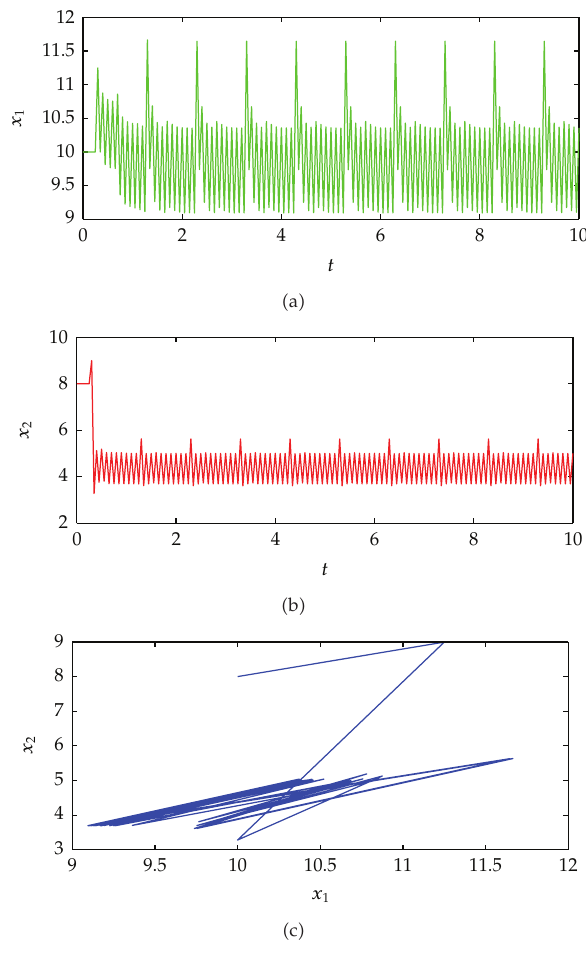
Figure 1: Dynamics of (cid:6) 4.2 (cid:7) — (cid:6) a (cid:7) time series of x 1 , (cid:6) b (cid:7) time series of x 2 , and (cid:6) c (cid:7) portrait of (cid:6) x 1 ,x 2 (cid:7)